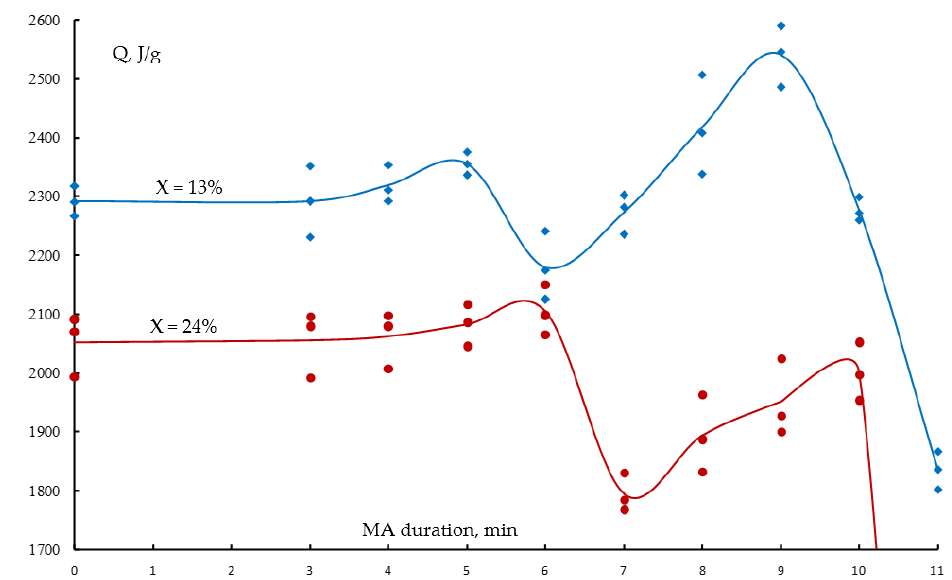
Figure 3. Dependence of the specific heat of combustion on the duration of the MA of the Ti–C–Co–Ca 3 (PO 4 ) 2 –Ag–Mg powder mixtures at X = 13% and Ti – C – Co – Ca 3 (PO 4 ) 2 – Ag – Mg powder mixtures at X = 13 and 24%.